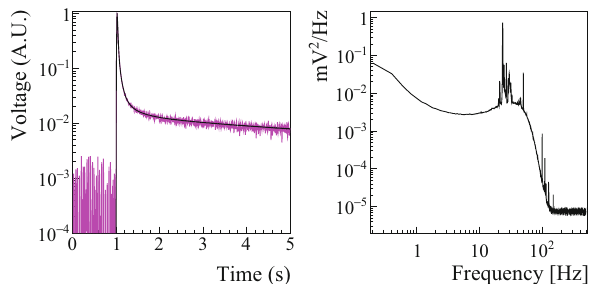
Fig. 2 Left: decay-time (see definition in text) of pulses recorded by a ZnSe crystal as a function of the energy. Right: same parameter after the removal of the